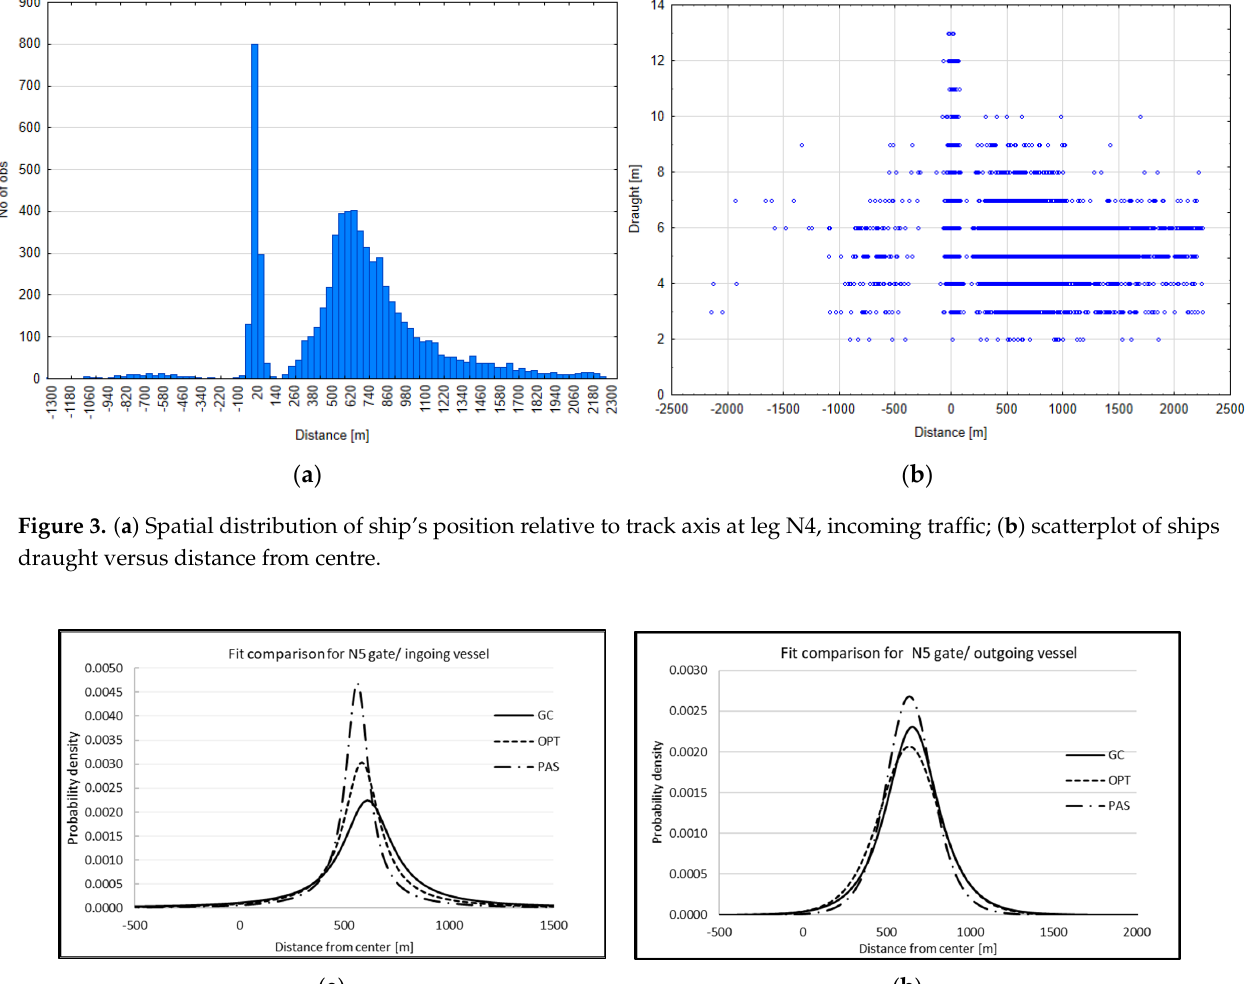
Figure 4. ( a ) Spatial distribution of ship hull position relative to track axis at cross-section N5 for three ship types, outside the marked fairway for inbound and ( b ) outbound ships.